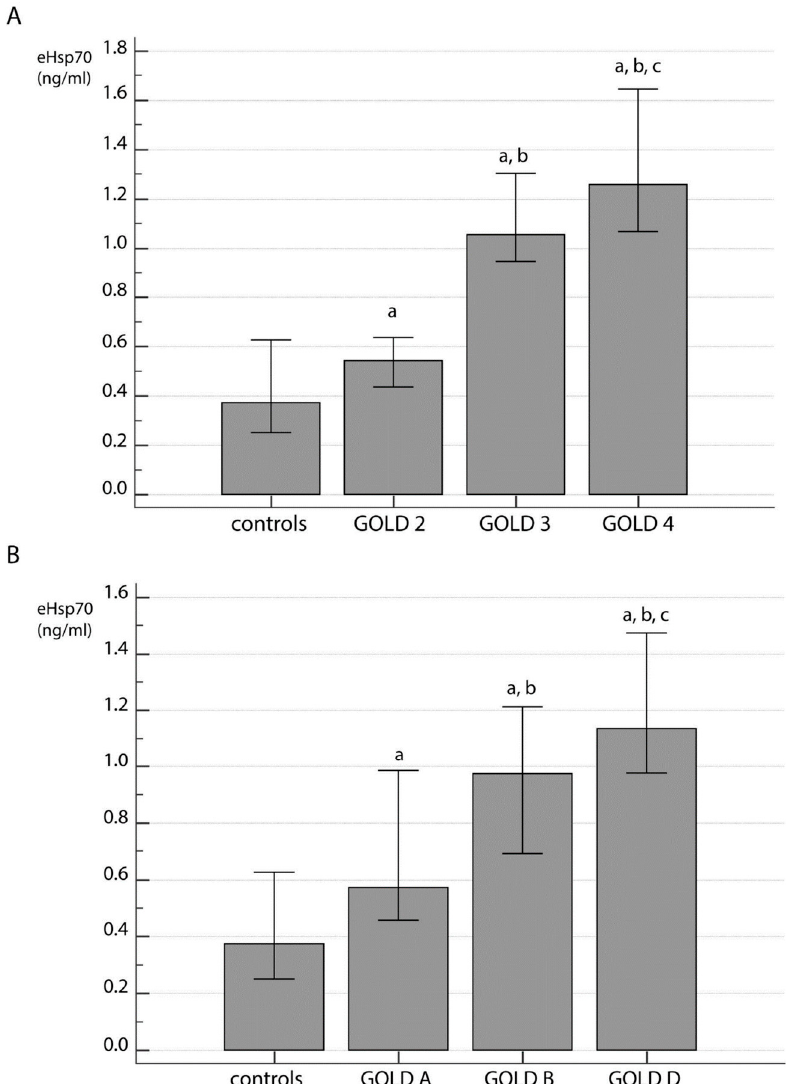
Figure 1. Concentration of eHsp70 in plasma of COPD patients regarding forced expiratory volume in one second (FEV 1 )-based classification by Global Initiative for COPD (GOLD) ( A ) and ABCD classification based on symptoms severity and history of exacerbations ( B ). All data were presented as median with interquartile range. Statistical analysis was performed by Kruskal-Wallis one way analysis of variance on ranks. a statistically significant increase in eHsp70 concentration in comparison to controls; b statistically significant increase in eHsp70 concentration in comparison to GOLD 2 ( A ) or GOLD A ( B ); c statistically significant increase in eHsp70 concentration in comparison to GOLD 3 ( A ) or GOLD B ( B ).